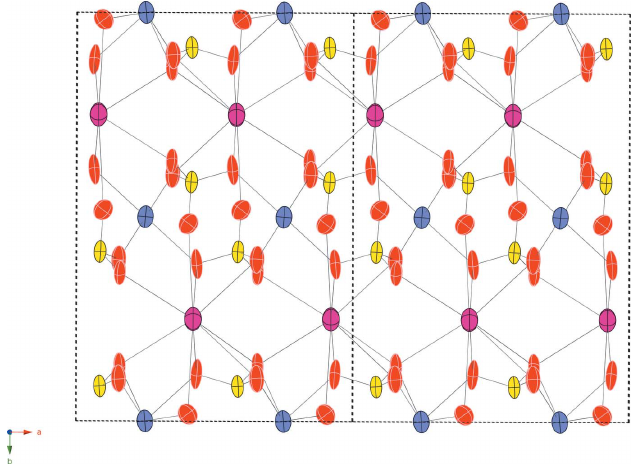
Figure 2 Polyhedral representation of CsNd(SO 4 ) 2 . Sulfate tetrahedra are yellow, NdO 8 polyhedra are pale-lavender and Cs + cations in magenta. Outlines of the unit cell are shown as dotted black lines.